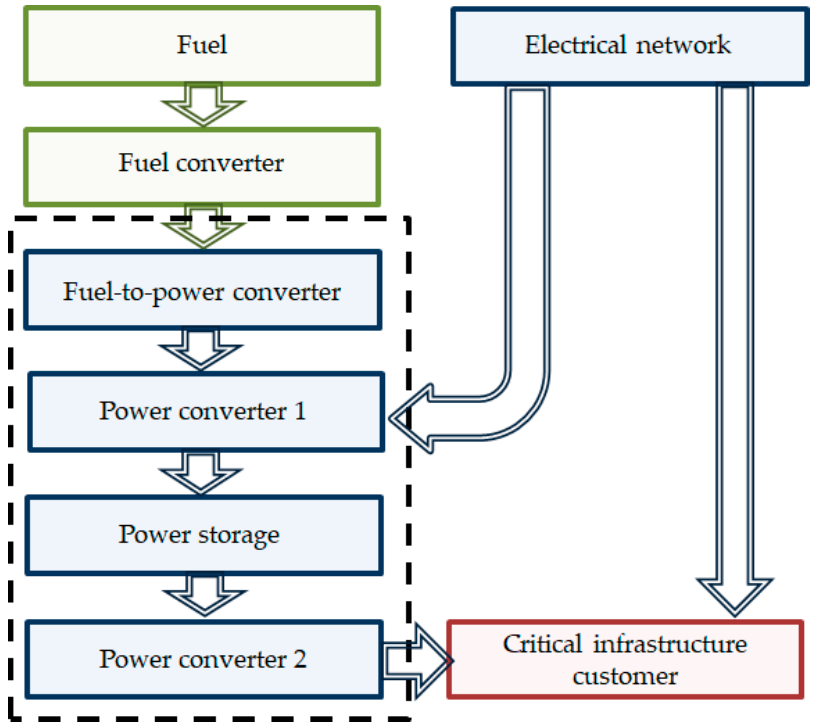
Figure 1. Structure of local power sources for critical infrastructure customers. The brief characteristics of the flow chart components are presented below.